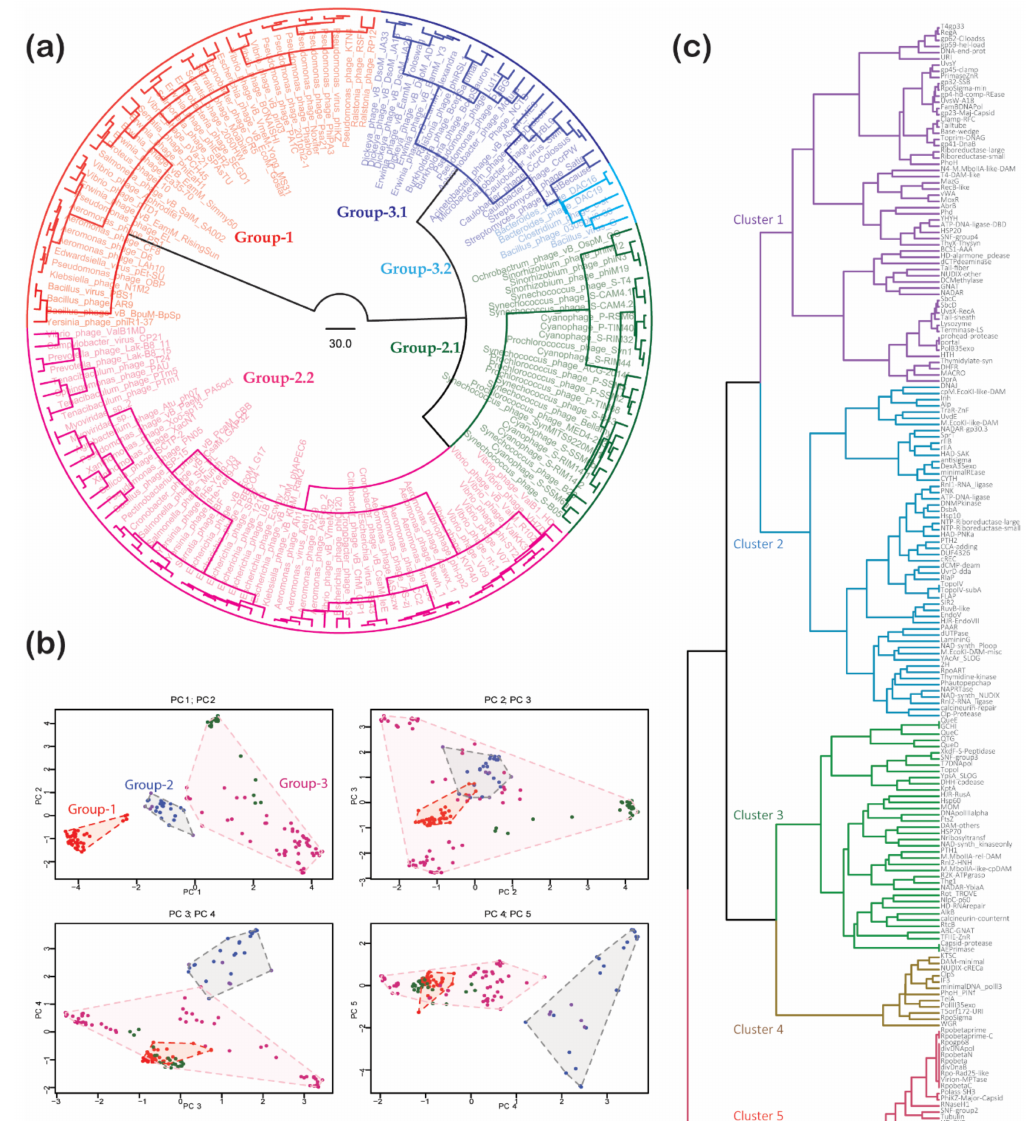
Figure 2. Phylogenetic analysis of jumbo phages and their proteins. Phyletic patterns of 113 protein families were used to ( a ) compute the Canberra distance for Ward’s clustering to construct a dendrogram of phages, and ( b ) for Principle Component Analysis for 154 jumbo phages with unique phyletic patterns. The convex hulls bounding the groups are shown on the Principal Component Analysis (PCA) plots. Members groups 1, 2.1, 2.2, 3.1 and 3.3 are colored distinctly. Organisms are colored by groups as in ( a ). The Canberra distance and Ward’s clustering were also used to compute the ( c ) protein dendrogram for 181 protein families which illustrates proteins sharing similar phyletic